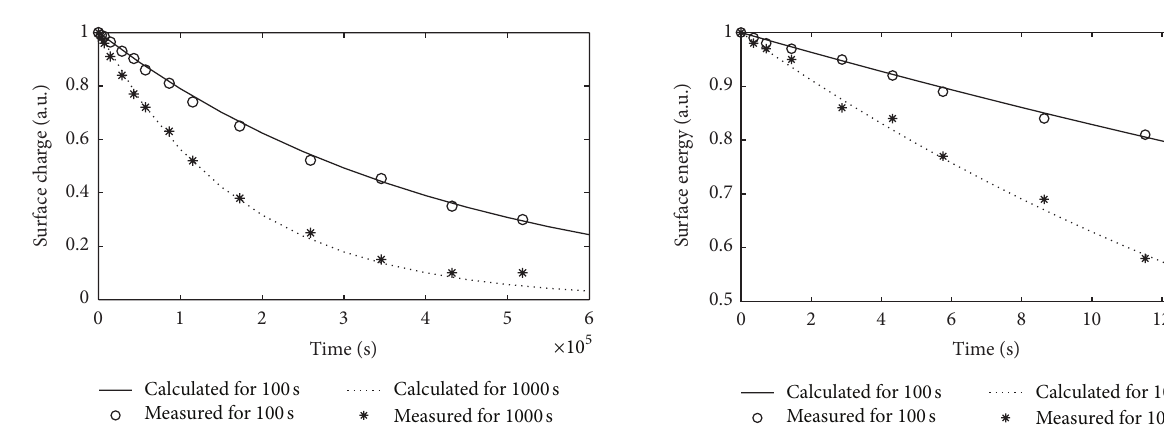
Figure 3: The variation of normalized surface charge density (𝜎/𝜎 𝑚 ) versusdecaytimeforthesampleexposedtoDBDinSF 6 for100sand 1000s (𝜎 100 𝑚 = 7.86 ⋅ 10 4 nC / m 2 , 𝜎 1000 𝑚 = 17.47 ⋅ 10 4 nC / m 2 ) .